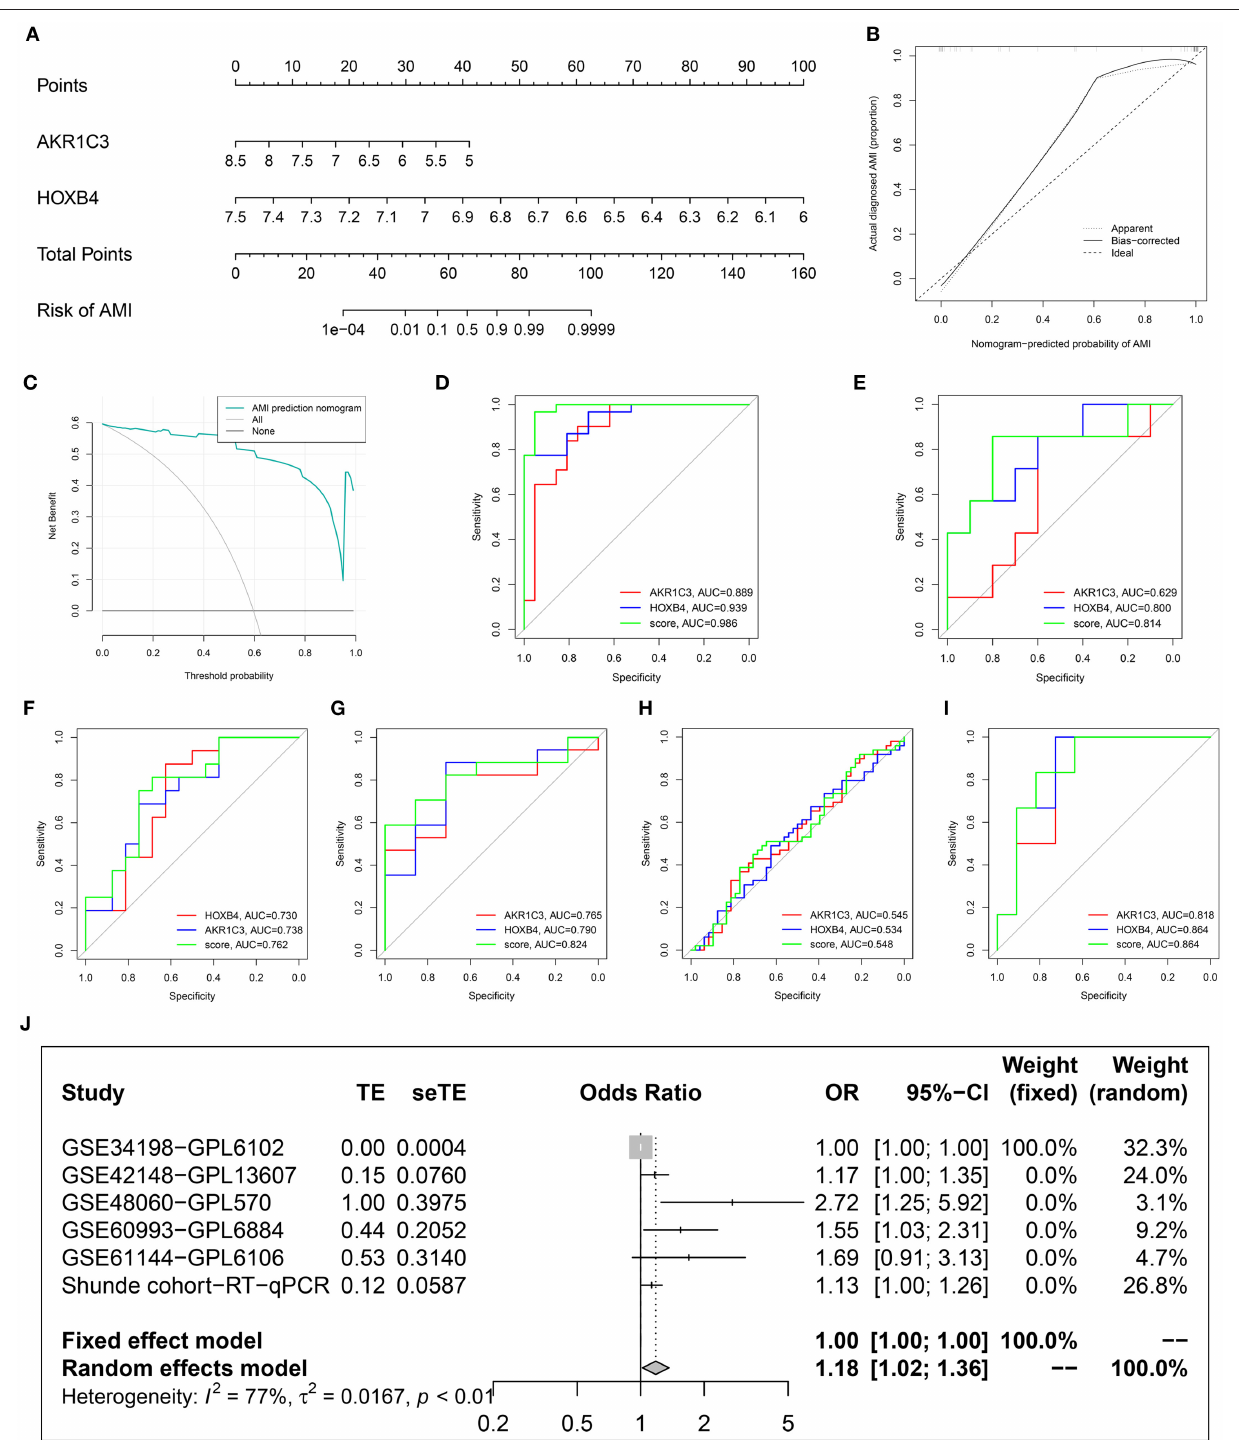
Frontiers in Cardiovascular Medicine |